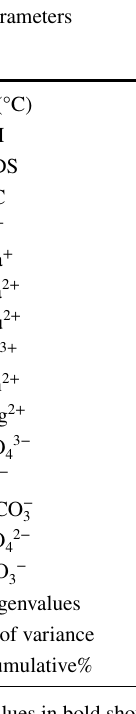
Values in bold showed high positive loadings at